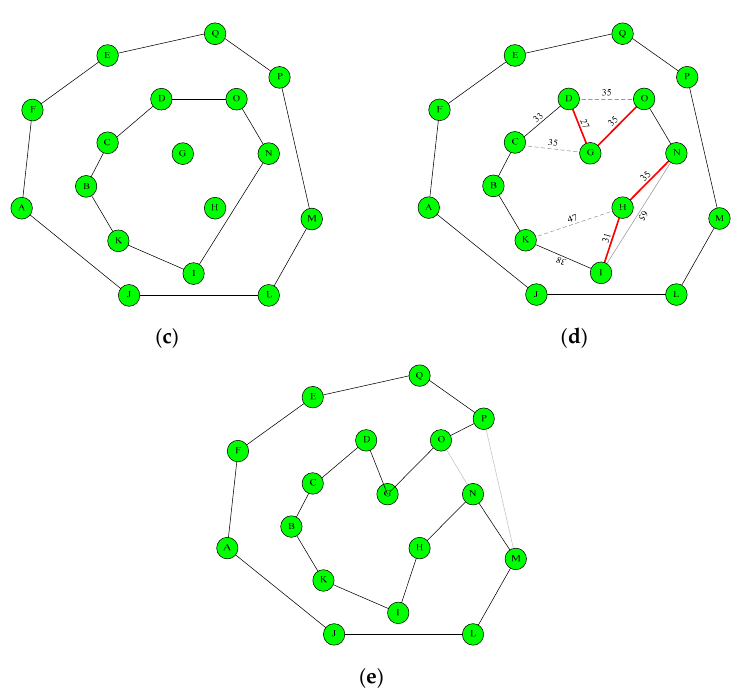
Figure 1. Construct regular itinerary for mobile chargers. ( a ) chain the sensors starting from node A and greedily select the next one which has the shortest distance; ( b ) remove the cross edges CD and FG in (a) to shorten the total distance of chain; ( c ) construct multiple non-overlapped circles by using convex-hull algorithm; ( d ) merge the inner nodes G and H to adjacent outer convex-hull chain; ( e ) the final merged chain of the multiple non-overlapped circles in (c) .